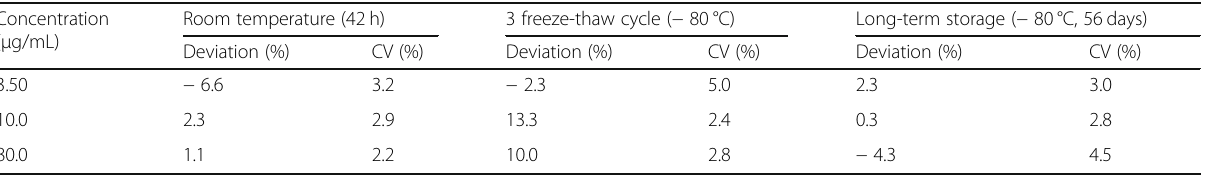
Table 4 Urine stability experiment ( n = 3)